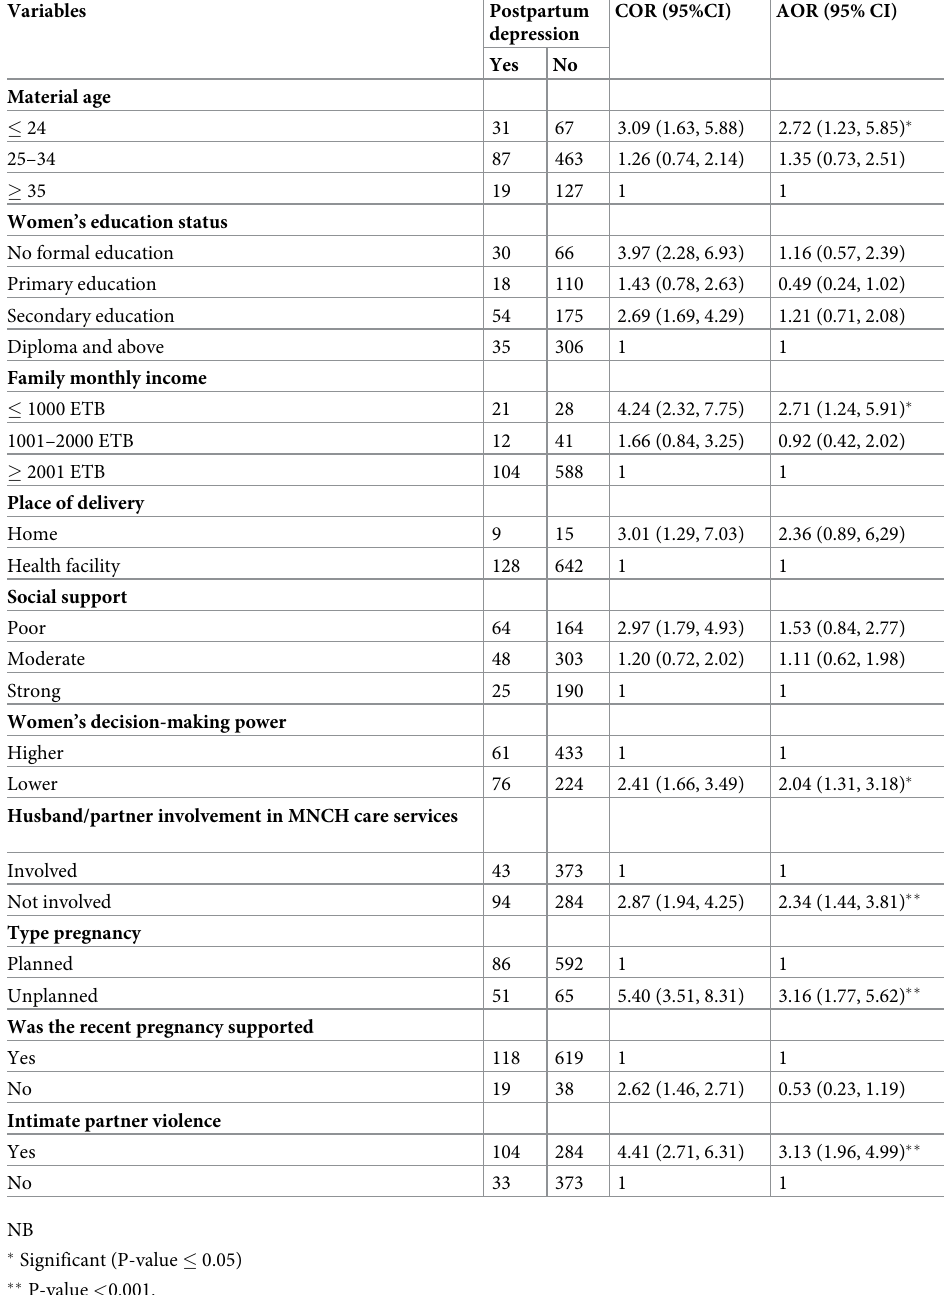
Table 3. Bivariable and multivariable logistic regression analysis of associated factors of postpartum depression among women who gave birth in the last 1 year in Gondar city, northwest Ethiopia, 2021 (n =